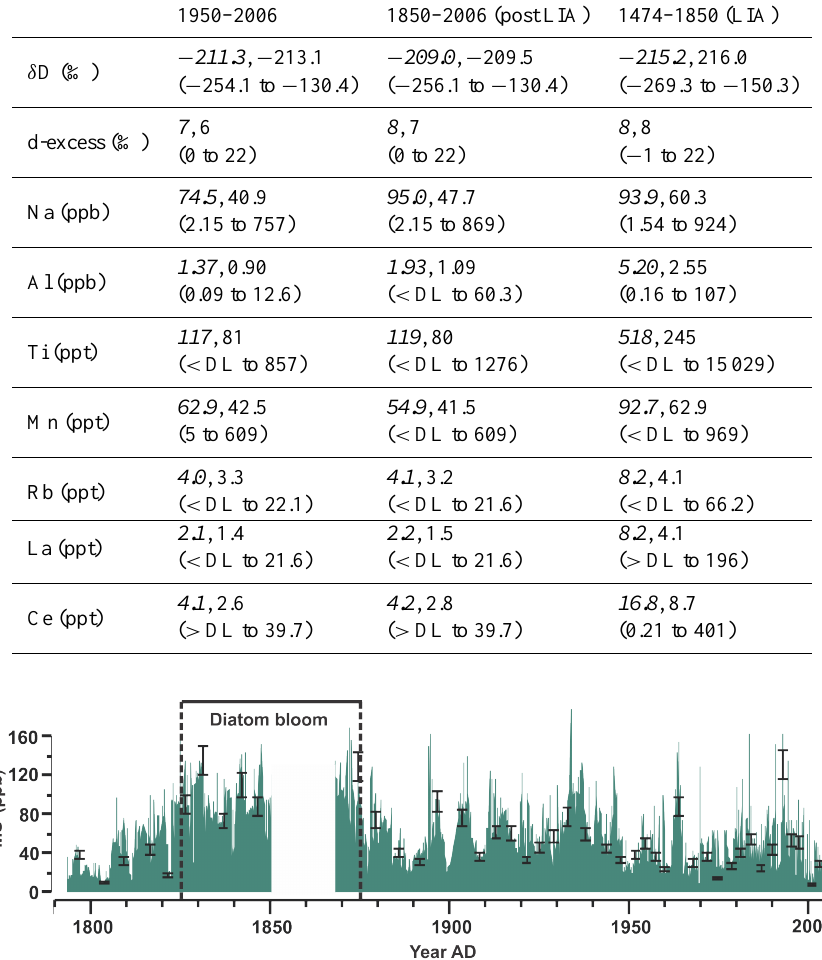
Figure 9: MS - data for the MES ice core plotted with the timing of a diatom bloom reported by Leventer and Dunbar (1988) in two sediment core records from McMurdo Sound, to the west of Ross Island. Representative analytical error bars ( ± 2 σ ) are displayed on selected points. A gap in the time series exists because some samples were not analysed for MS − concentration.